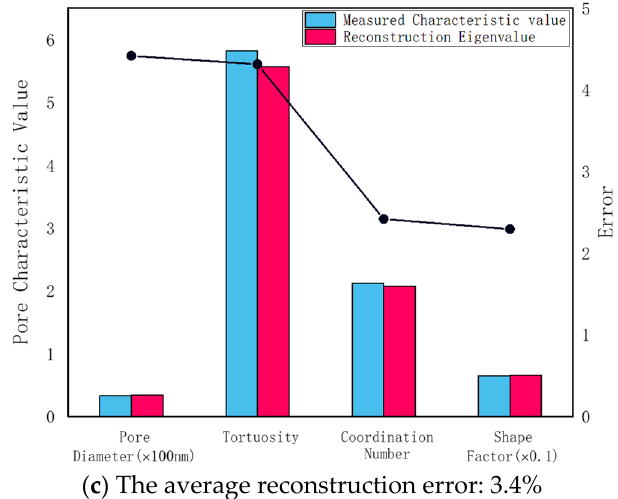
Figure 10. Reconstructed digital core of shale with an average pore–throat diameter of 30 nm.